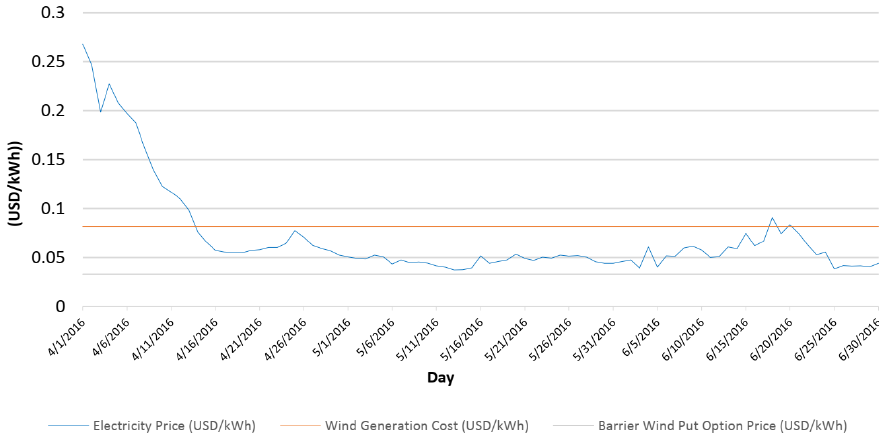
Figure 6. Comparison of electricity prices without the El Niño phenomenon, cost of generation of wind and wind put barrier option price (1 April 2016–30 June